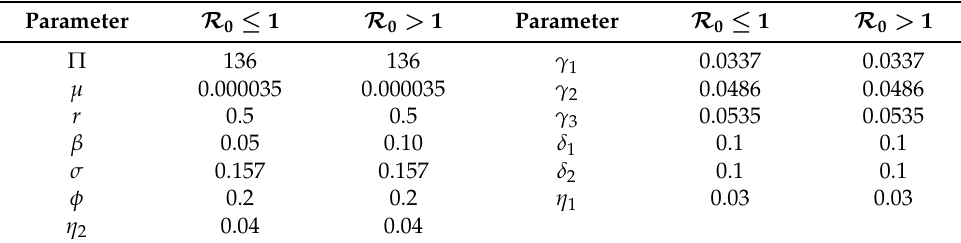
Table 1. The values of the parameters of model (1) when R 0 ≤ 1 and when R 0 > 1.